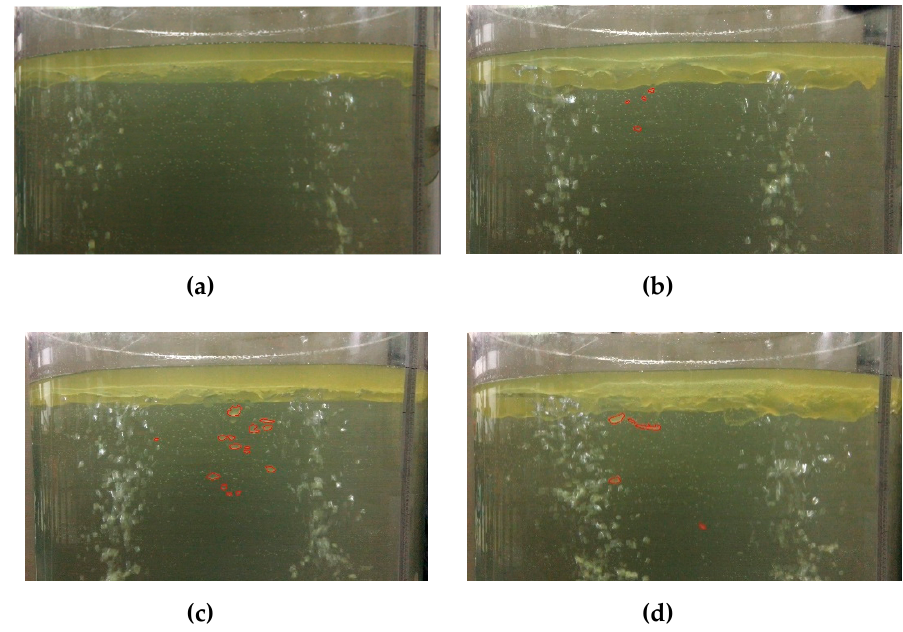
Figure 7. Entrapment in the water model at a di ff erent bottom flow rate (16 mm OLT): ( a ) Q = 0.095 m 3 / h; ( b ) Q = 0.191 m 3 / h; ( c ) Q = 0.286 m 3 / h; ( d ) Q = 0.381 m 3 / h.